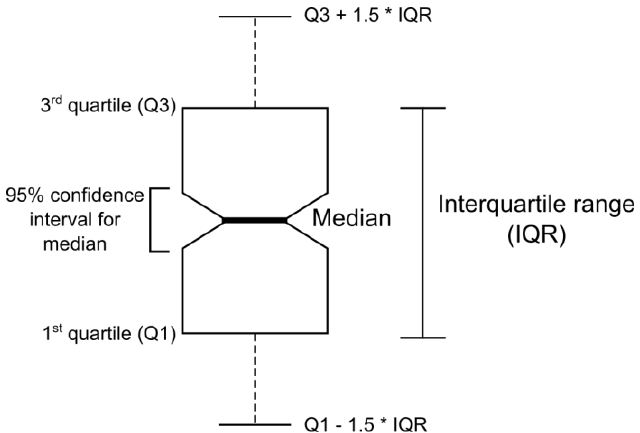
Figure 4. Explanation of structural elements of boxes used in box plot.